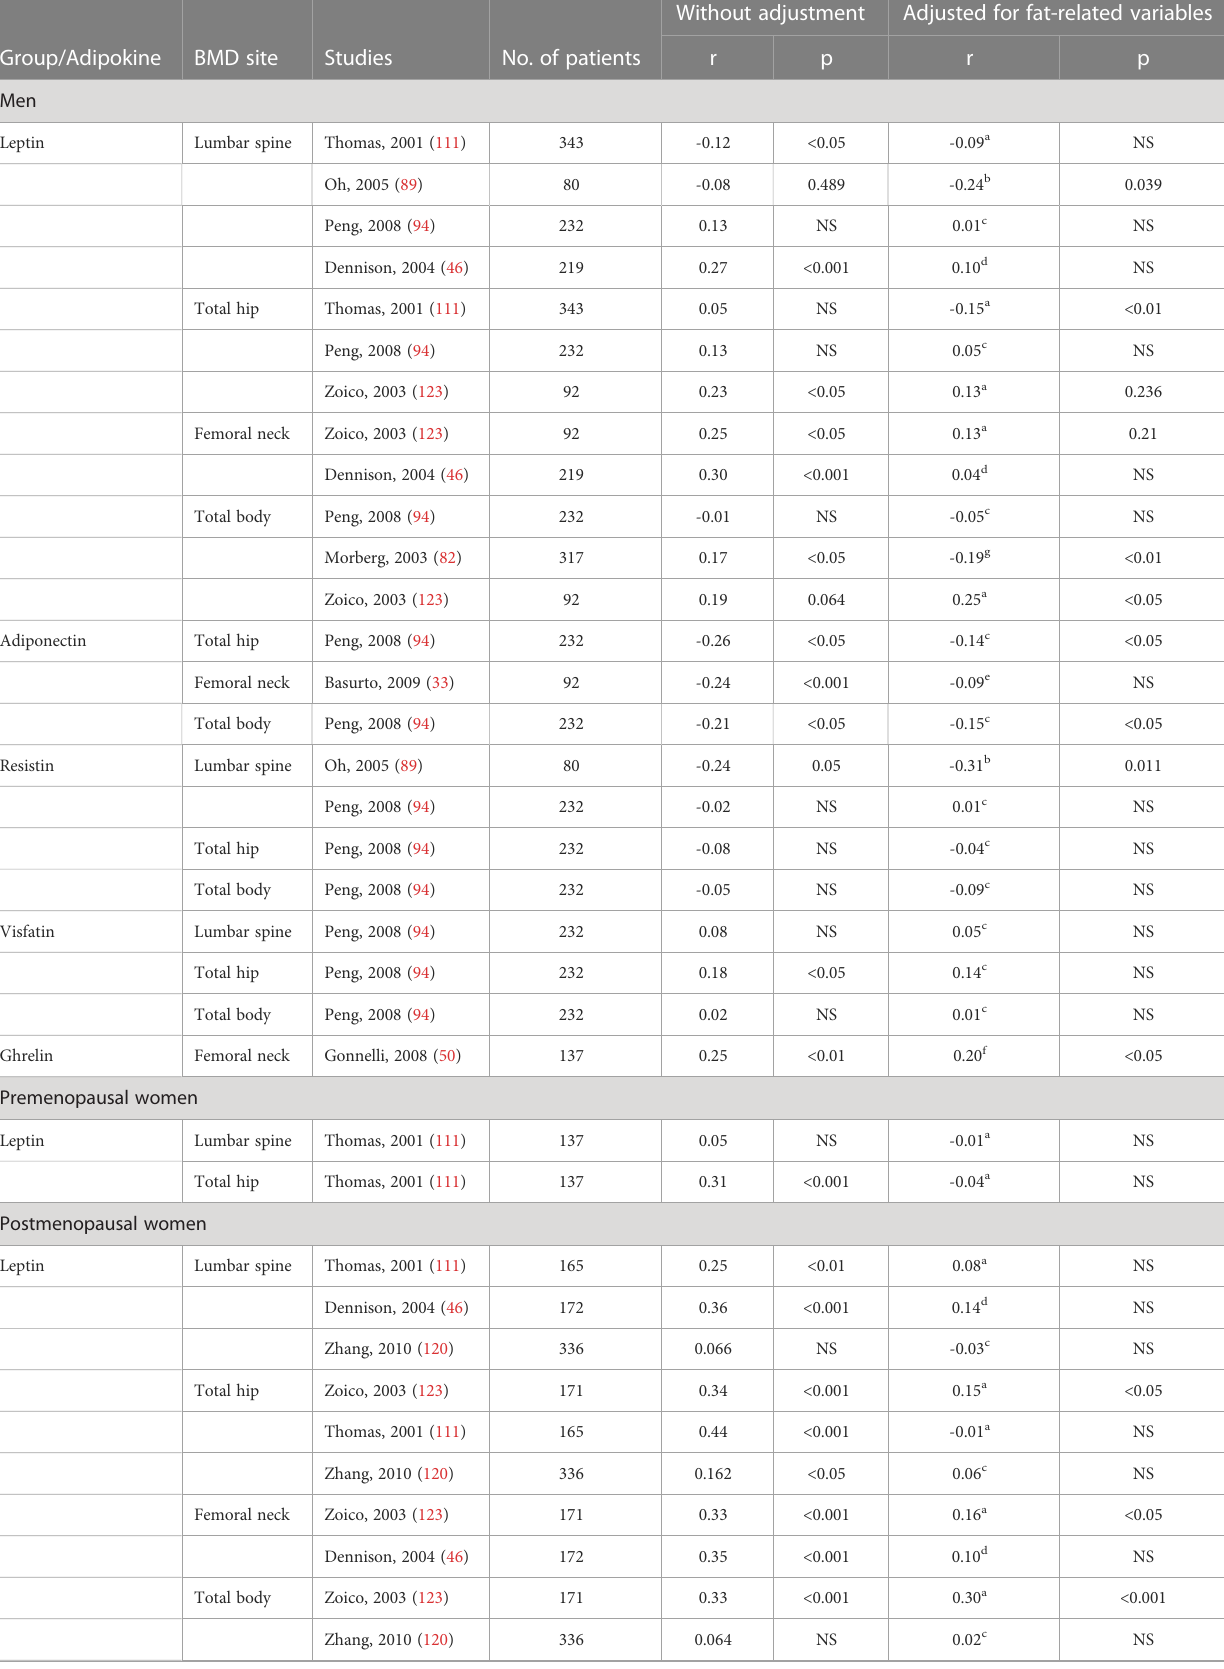
TABLE 3 Non-adjusted and adjusted correlations between adipokines or ghrelin levels and BMD according to sex and menopausal status.